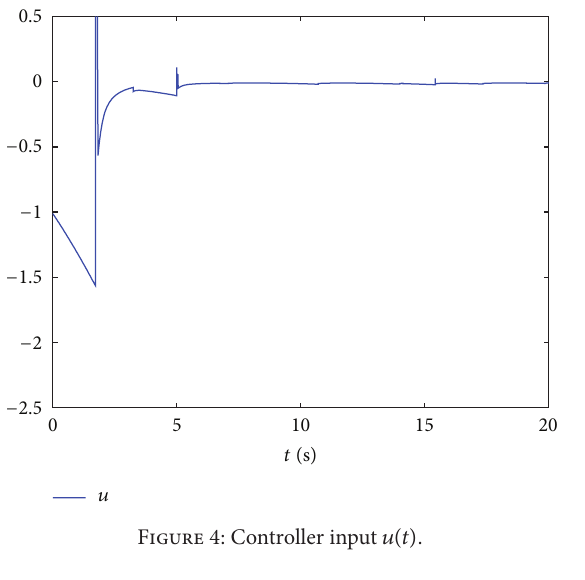
Figure 4: Controller input 𝑢(𝑡)